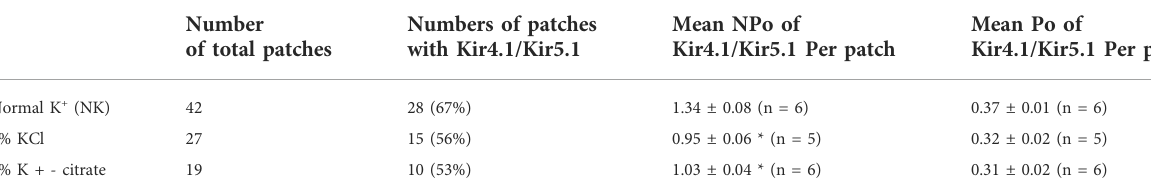
TABLE 1 Effect of 5% KCl and K + − citrate on the probability of fi nding Kir4.1/Kir5.1 in the basolateral membrane of the DCT, mean NPo and mean Po per patch in the male mice. Asterisk indicates the signi fi cant difference in comparison to the group on NK. Numbers.